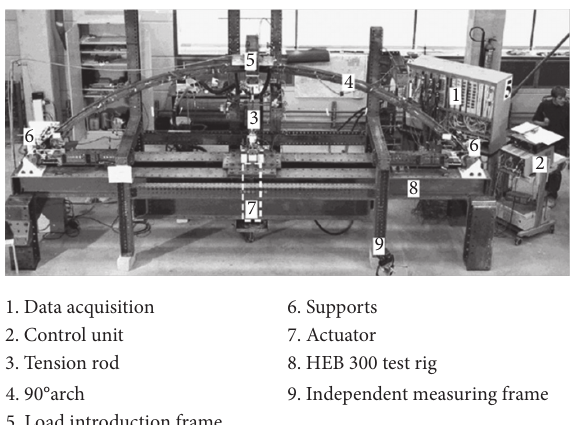
Figure 1: Test setup with 90 ° arch [2,